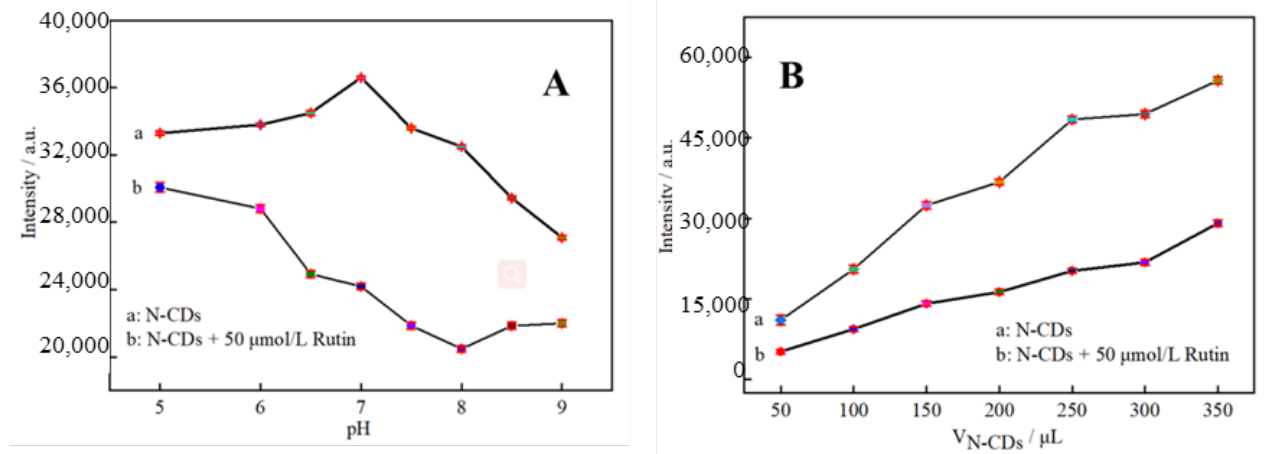
Figure 5. Fluorescence response of N-CDs as a function of pH ( A ) and dosage ( B ) ( n = 6). Subsequently, 50, 100, 150, 200, 250, 300, and 350 µ L of N-CDs dispersion was added in sequence into 10 mL colorimetric tubes with and without 50 µ L of 0.01 mol/L rutin standard solution. The volume was adjusted with a PBS solution of pH = 7.0, and the results are shown in Figure 5B. In the absence of rutin, the dosage of N-CDs rose along with the fluorescence intensity F 0 . Regardless of how many N-CDs were utilized, rutin had a specific fluorescence-quenching effect on N-CDs, the intensity of which was referred to as F. Due to the abundance of –OH and C–O groups present in both rutin and the N-CDs produced by employing citric acid as the carbon source, strong hydrogen bonds may be formed upon the addition of rutin into the N-CDs solution. It is hypothesized that the fluorescence-quenching process may be triggered by the fluorescence resonance energy transfer and internal filtration effect between N-CDs and rutin after bonding to the surface through hydrogen bonds [31]. Rutin functions as an energy acceptor after fluorescence emission. Calculating F = F 0 − F, the results revealed that the fluorescence quenching effect was best when 250 µ L of N-CDs dispersion was present. N-CDs were, thus, added to the reaction system in a volume of 250 µ